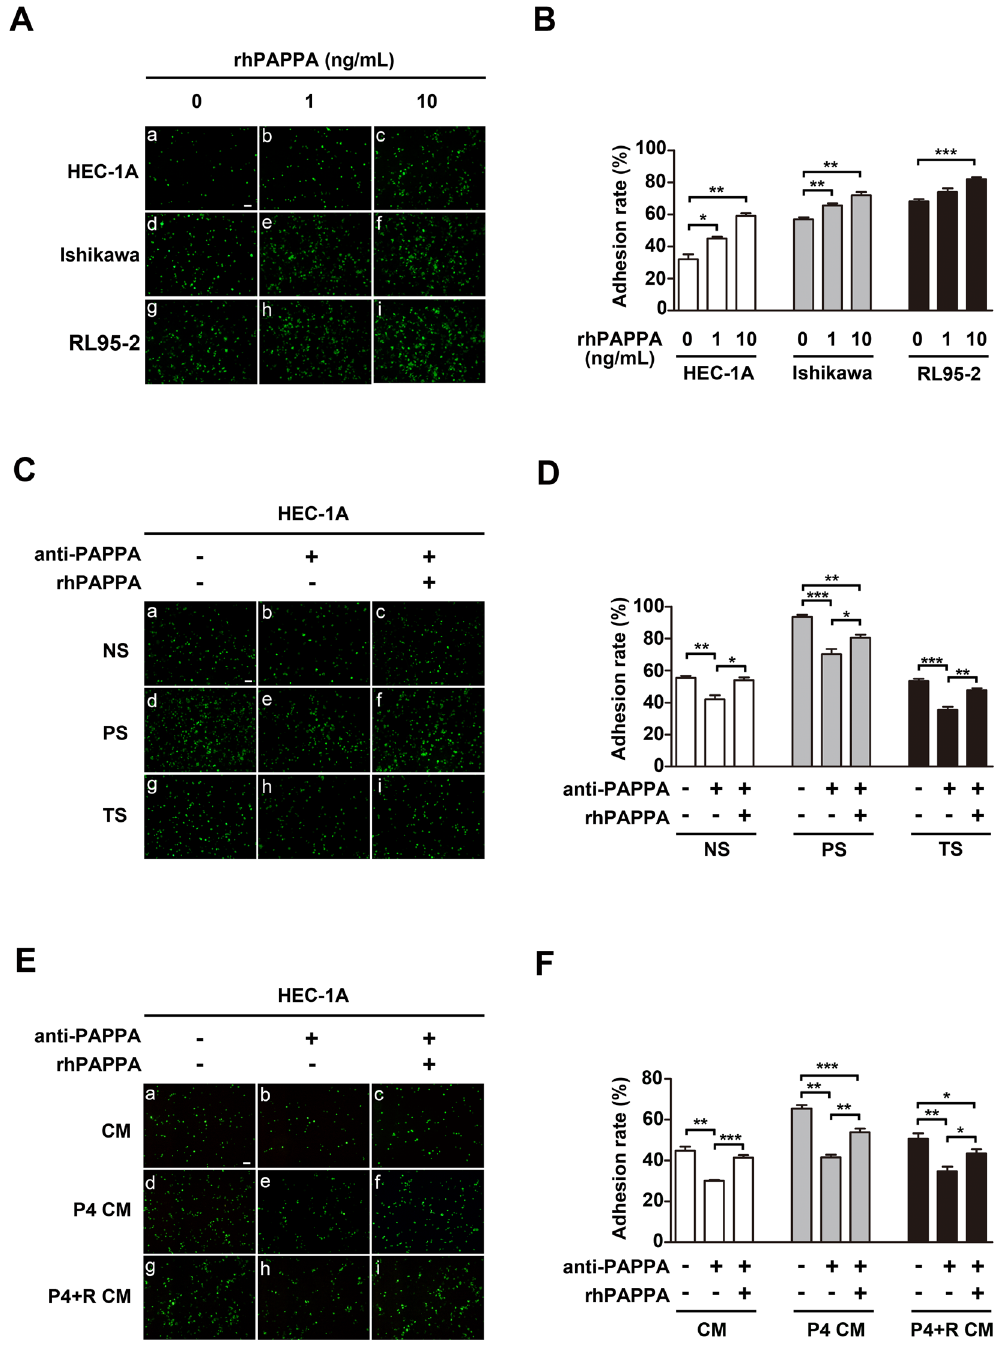
Figure 1. PAPPA promotes human endometrial cell receptivity. HEC-1A, Ishikawa and RL95-2 cell monolayers were differently pre-treated as indicated before CMFDA-stained JAR cells (green) were plated. ( A,C,E ) Attached JAR cells were photographed after 1 h under a fluorescenct microscope, (B,D,F ), the respective adhesion rate was calculated as the percentage of attached JAR cells. ( A ) HEC-1A, Ishikawa and RL95-2 cells were pre-treated with different doses of rhPAPPA (1 ng/ml and 10 ng/ml) for 48 h. ( C ) HEC-1A cells were pre-incubated with non-pregnancy serum (NS) (a–c), pregnancy serum (PS) (d–f), and threatened abortion serum (TS) (g–i) in the absence (a,d,g), or presence of anti-PAPPA (b,e, h) and anti-PAPPA plus rhPAPPA (c,f,i). (E) HEC-1A cells were pre-incubated with conditional medium (CM) from JAR cells (a–c), CM after JAR cells were treated with progesterone (100 μ M) (P4 CM) (d–f), CM after JAR cells were treated with progesterone (100 μ M) plus RU486 (10 μ M) (P4 + R CM) (g–i) in the absence (a,d,g), or presence of anti-PAPPA (b,e,h) and anti-PAPPA plus rhPAPPA (c,f,i) before JAR cells were added. * p < 0.05, ** p < 0.01, *** p < 0.001. The bar represents 100 μ m. The data were presented as the mean ± SEM of three independent